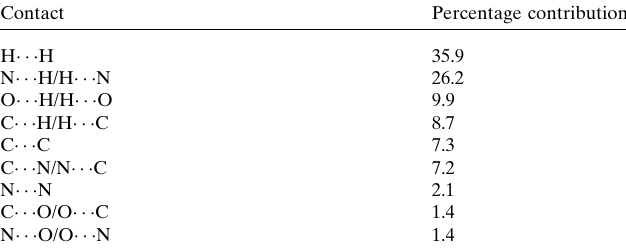
Table 3 Percentage contributions of interatomic contacts to the Hirshfeld surface for